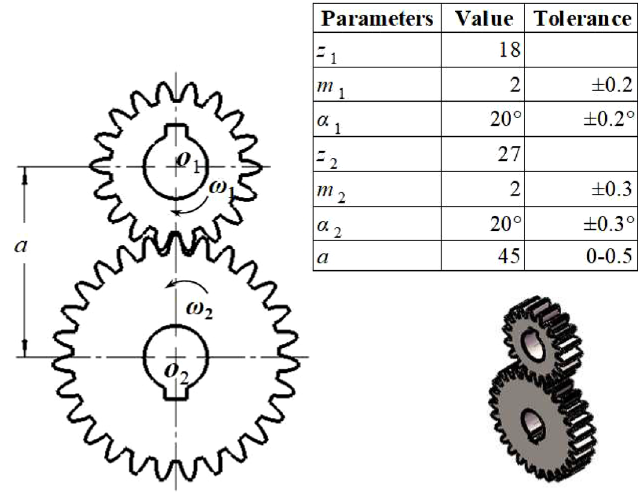
Fig. 5. Tolerance analysis of a